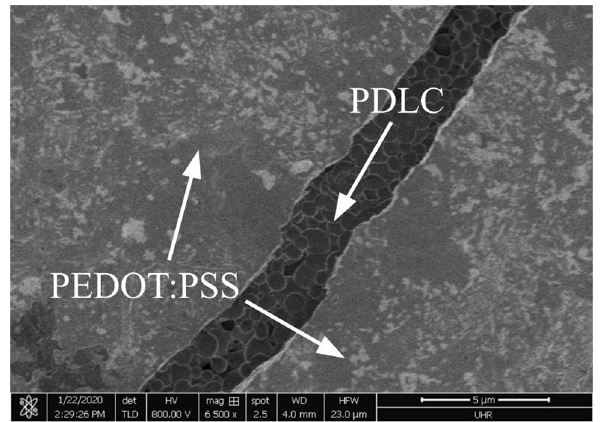
Figure 7. An SEM image of a crack in the top PEDOT: PSS electrode. The LC domains are visible beneath.